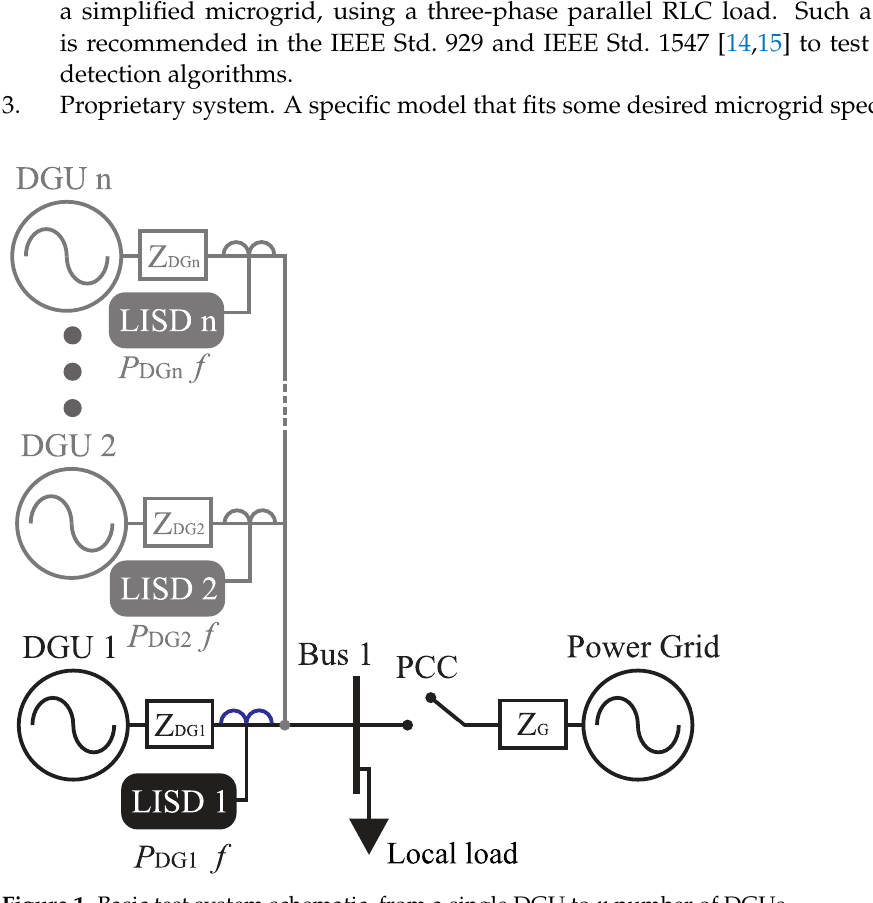
Figure 1. Basic test system schematic, from a single DGU to n number of